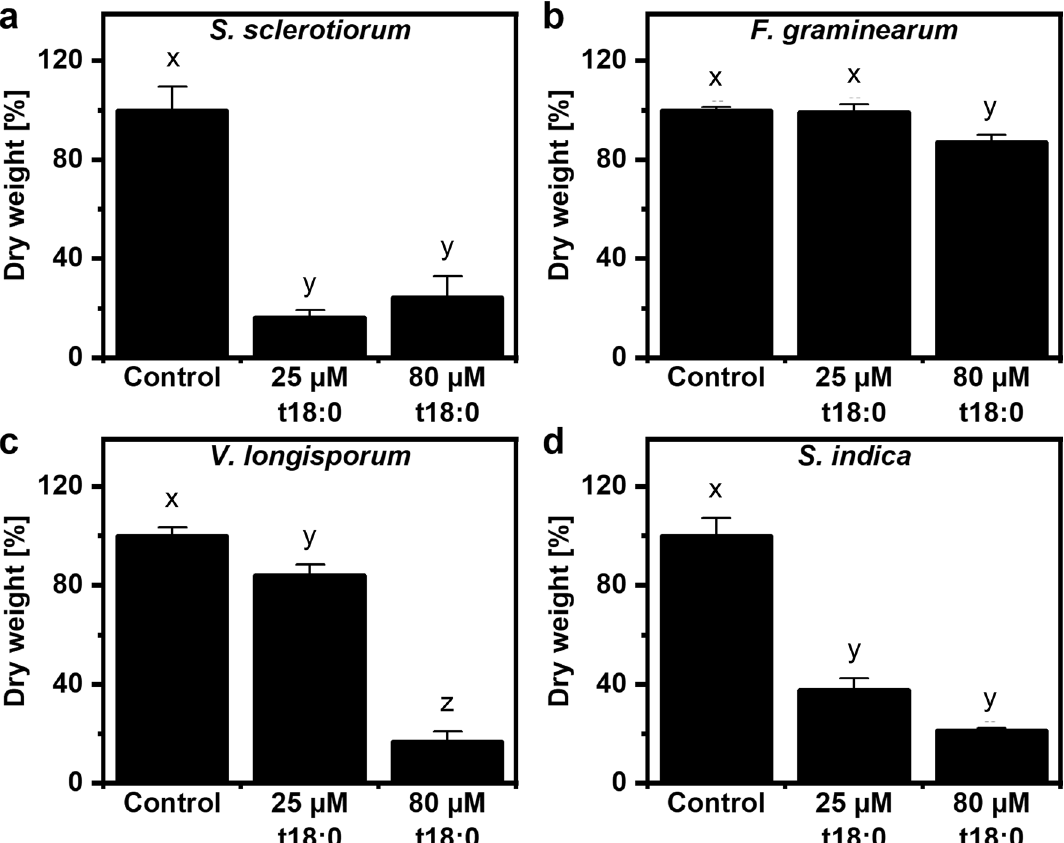
Figure 2. Phytosphingosine inhibits fungal growth in liquid medium. ( a ) Sclerotinia sclerotiorum , ( b ) Fusarium graminearum , ( c ) Verticillium longisporum and ( d ) Serendipita indica . Erlenmeyer flasks with 20 mL of medium were inoculated with a mycelial plug ( a , b , d ) or 10 µL of spore solution (containing 5000 spores) ( c ). The respective media either contained the indicated concentrations of phytosphingosine (t18:0), or solvent (1% DMSO; Control) only. Fungal dry weight was determined after several days of growth ( a , b : 5 days, c : 10 days, d : 12 days) by collecting and drying fungal mycelia on filter paper. Dry weight is expressed as percentage of the control treatment which was set to 100%. Values are means of four to eight flasks, with error bars indicating standard error of the mean (SEM). Different letters within each diagram indicate statistical differences according to Tukey-HSD (p < 0.05) after one-way